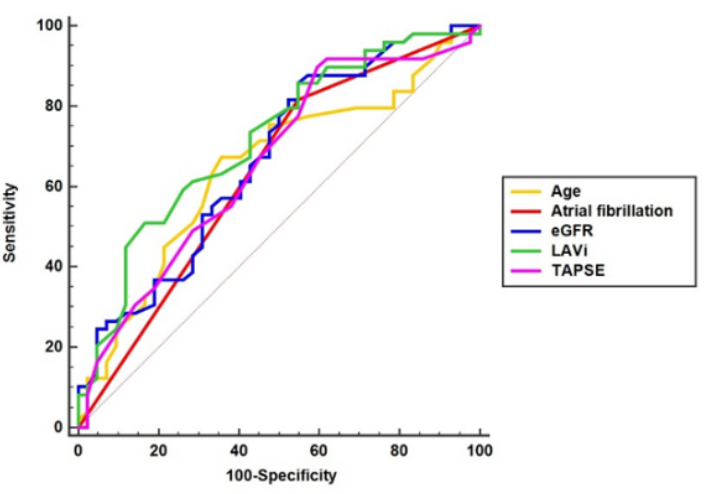
Figure 4. Predictors for raised NT-proBNP ≥ 2910 Figure 4 . Predictors for raised NT- proBNP ≥ 291 0 pg/mL.